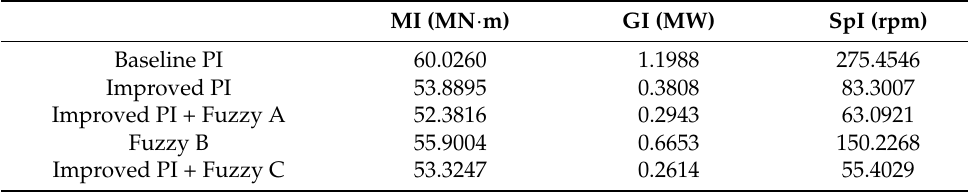
Table 8. Indexes for simulations with wind profile 2 (15 m/s A).